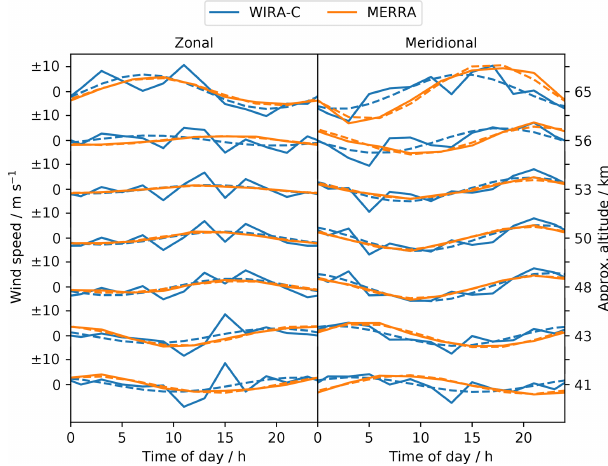
Figure 2. Mean daily cycle of zonal and meridional wind speeds at different altitudes for the 3 months during the tropical campaign from MERRA-2 and WIRA-C. Dashed lines indicate the best fit of the diurnal tide